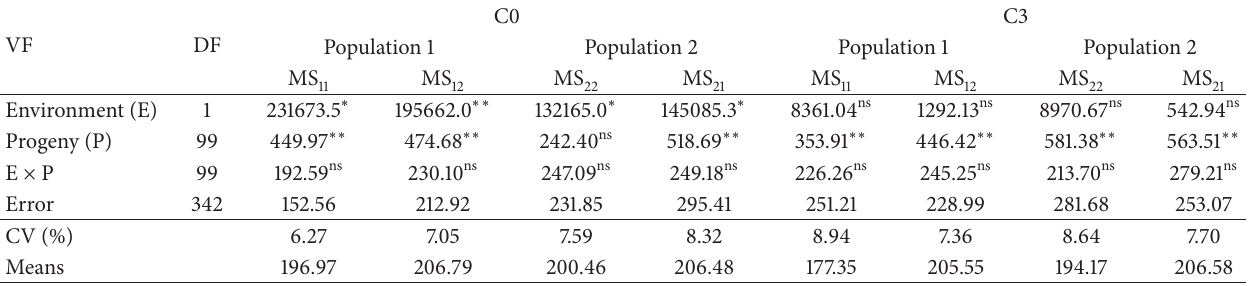
Table 2: Combined analysis of variance for plant height (PH cm/plant) to evaluate progenies of intra- and interpopulation half sibs from cycle 0 (C0) and cycle 3